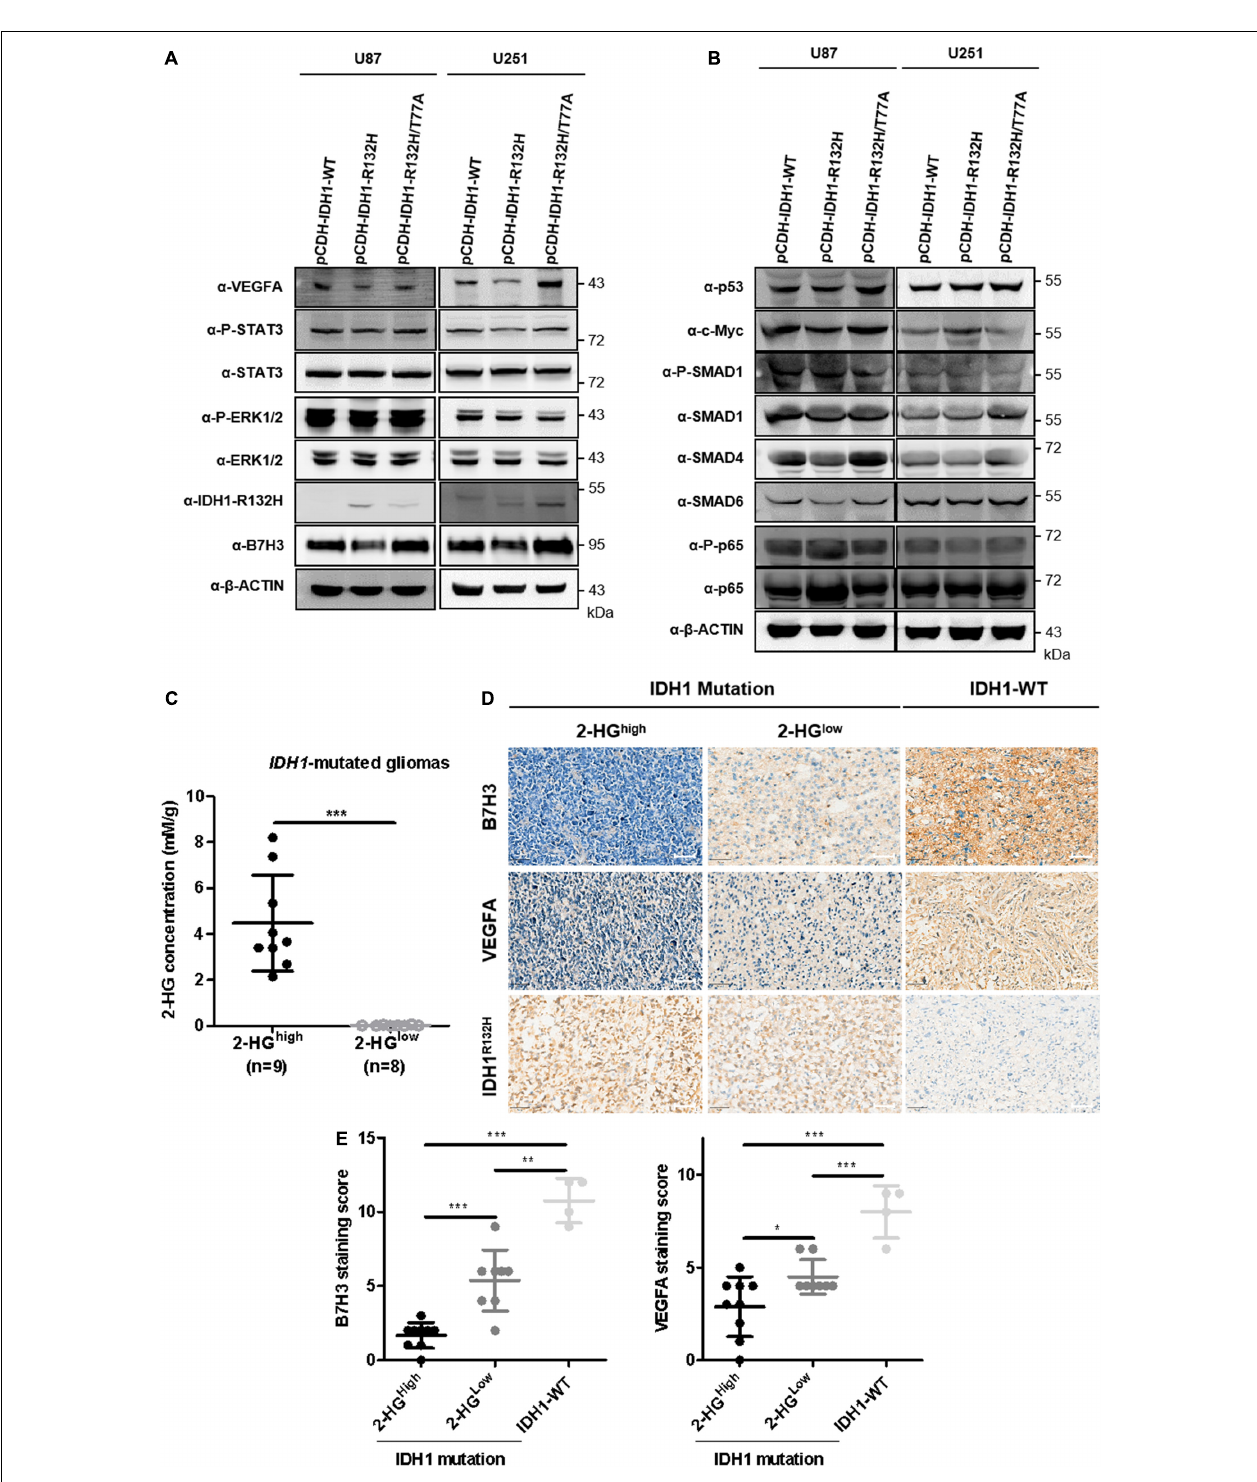
FIGURE 5 | B7H3 downregulation is associated with reduced expression of VEGFA in IDH-mutated gliomas. (A,B) VEGFA is reduced accompanied by decreased B7H3 expression in IDH1-R132H U87 and U251 cells. Stably expressed IDH1-WT, IDH1-R132H, and IDH1-R132H/T77A U87 and U251 cells were collected and immunoblotting was performed with the indicated antibodies. All experiments were performed in triplicate and representative results were shown. (C) Absolute 2-HG quantification in IDH1-mutated gliomas. N = 9 in 2-HG high and n = 8 in 2-HG low IDH1 -mutated gliomas, respectively. ***denotes the P < 0.001 for the indicated comparison. (D,E) B7H3 is positively associated with VEGFA in gliomas. IDH1-WT ( n = 4), 2-HG low IDH1-mutated gliomas ( n = 8), and 2-HG high IDH1-mutated gliomas ( n = 9) were used for IHC staining with the indicated antibodies (D) , scale bar = 50 µ M. Quantifications of B7H3 and VEGFA staining scores were shown in (E) . *denotes the P < 0.05, **denotes the P < 0.01, and ***denotes the P < 0.001 for the indicated